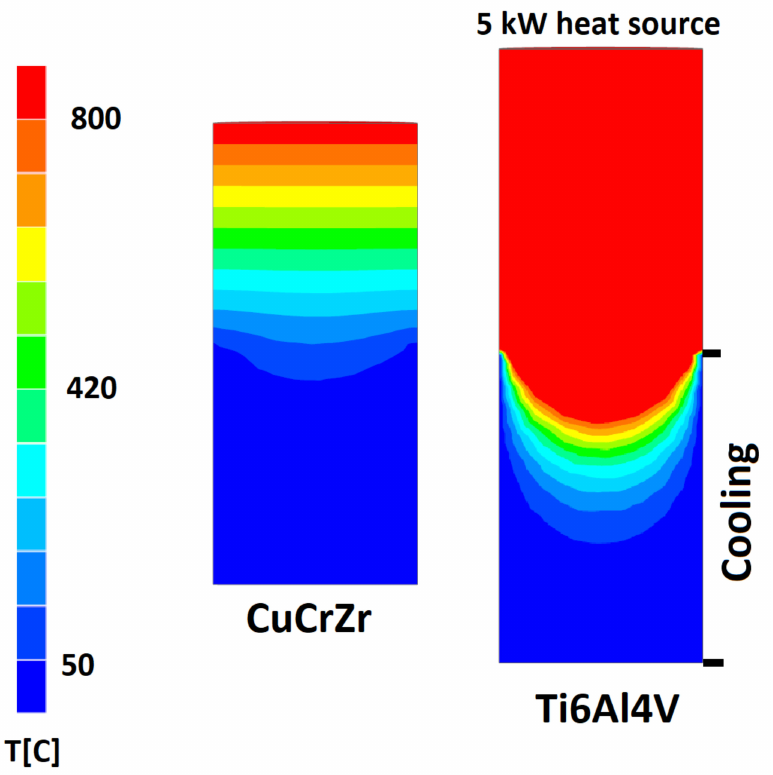
Figure 2. Temperature profile of 20 kHz Cu–Cr–Zr (Ampcoloy 972) and Ti–6Al–4V